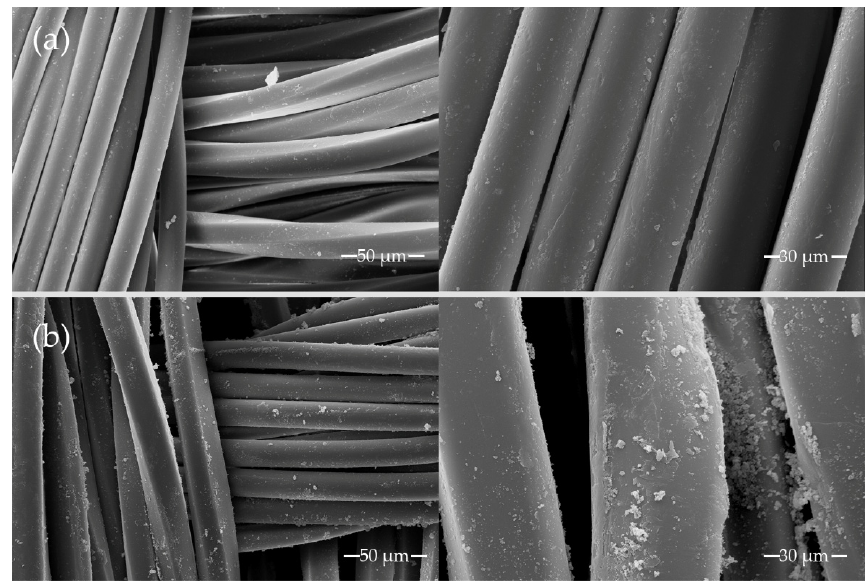
Figure 3. Scanning electron microscopy images of polyester fabrics after reducing bath. ( a ) Original simple, non-treated ( b ) treated with Ozone 20 min.